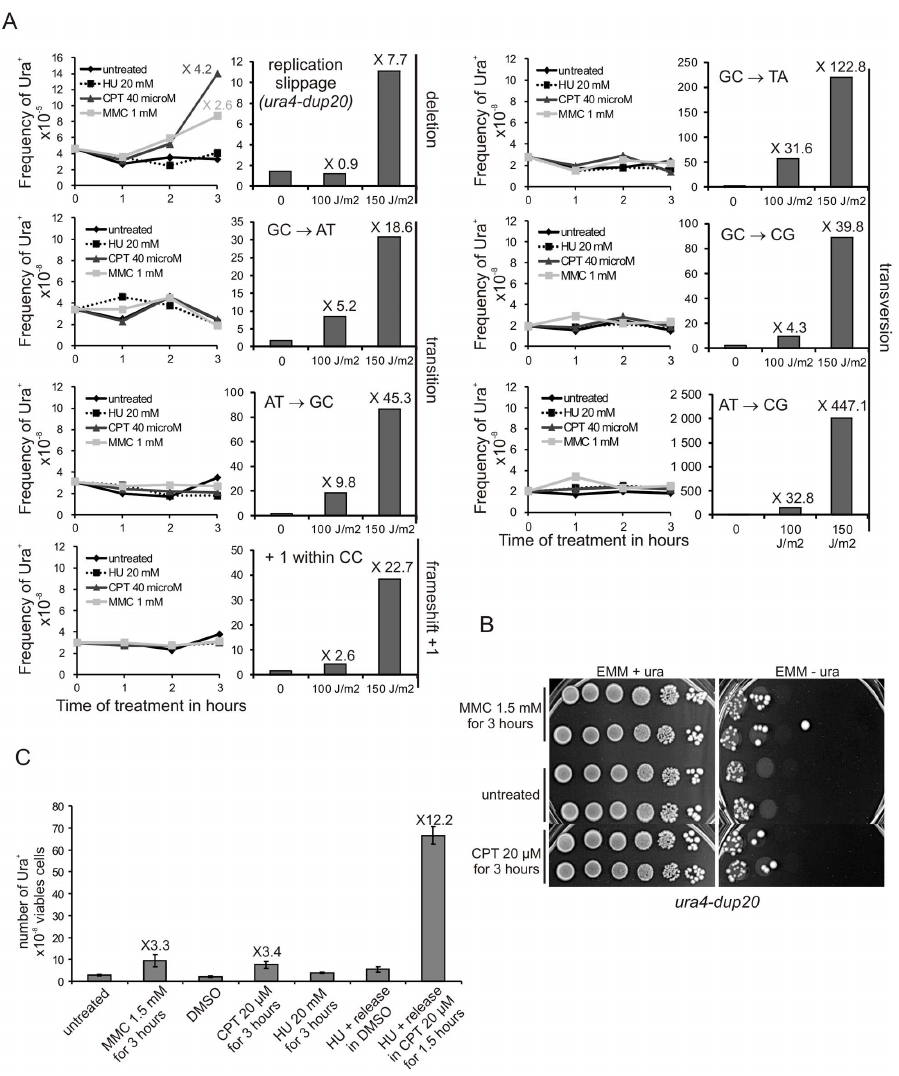
Figure 5. Collapsed forks, but not stalled forks, induce replication slippage. A. Left panel: the frequency of Ura + revertants as a function of time-contact with indicated drugs for the indicated ura4 alleles (single base-substitution, frame-shift, duplication of 20 nt). Right panel: the frequency of Ura + revertants in response to UV-C irradiation as a function of dose for the indicated ura4 alleles. The values reported are means of two independent experiments. Numbers indicate fold difference in the frequency of Ura + revertants between the treated and untreated control samples. For ura4 alleles containing base-substitutions or frame-shifts, the mutation event required to obtain Ura + revertants is indicated on the figure. B. Serial tenfold-dilutions from ura4-dup20 strain spotted onto the media indicated after treatment with MMC or CPT as indicated. C. Frequency of Ura + revertants after the indicated treatments in the ura4-dup20 strain. DMSO (the vehicle) was used as control for CPT treatment. The values reported are means of at least three independent experiments. Error bars correspond to